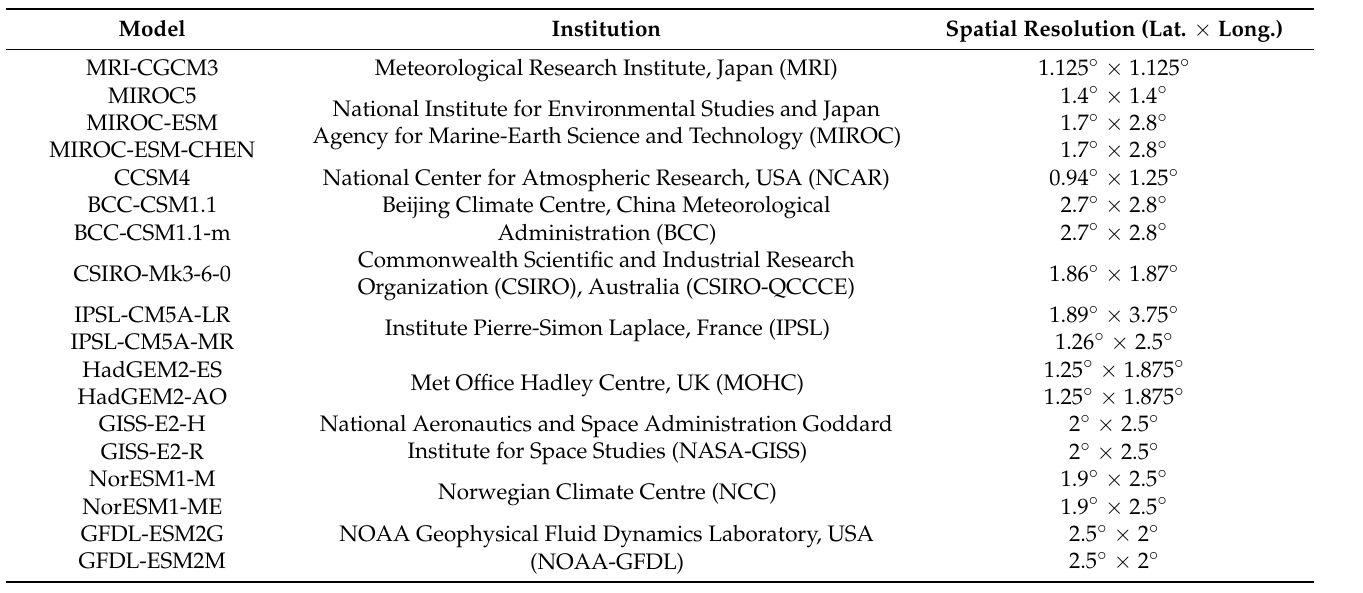
Table 2. The CMIP5 monthly models used in this